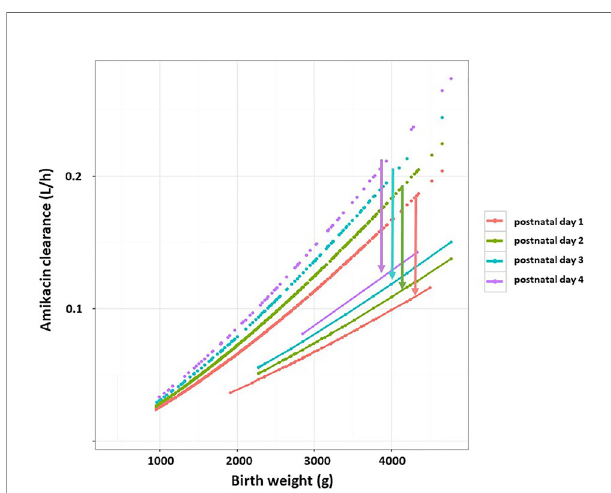
FIGURE 2 | Estimates of amikacin clearance (L/h) trends in early neonatal life based on pooling of reported datasets (dashed lines). There is a maturational trend in clearance related to birth weight (g) and postnatal age (PNA, days 1,2,3,4, as re fl ected by the colors) compared to a subgroup of term neonates undergoing therapeutic hypothermia as treatment for perinatal asphyxia (solid lines) (Cristea et al., 2017). The arrows indicate the difference in clearance between both cohorts for the respective PNA. Adapted from De Cock et al., antibiotic dosing in pediatric critically ill patients, Chapter in Antibiotic pharmacokinetic/pharmacodynamic considerations in the critically ill , Springer Nature Signapore 2018:239 – 263, with permission from Springer Nature (De Cock et al.,